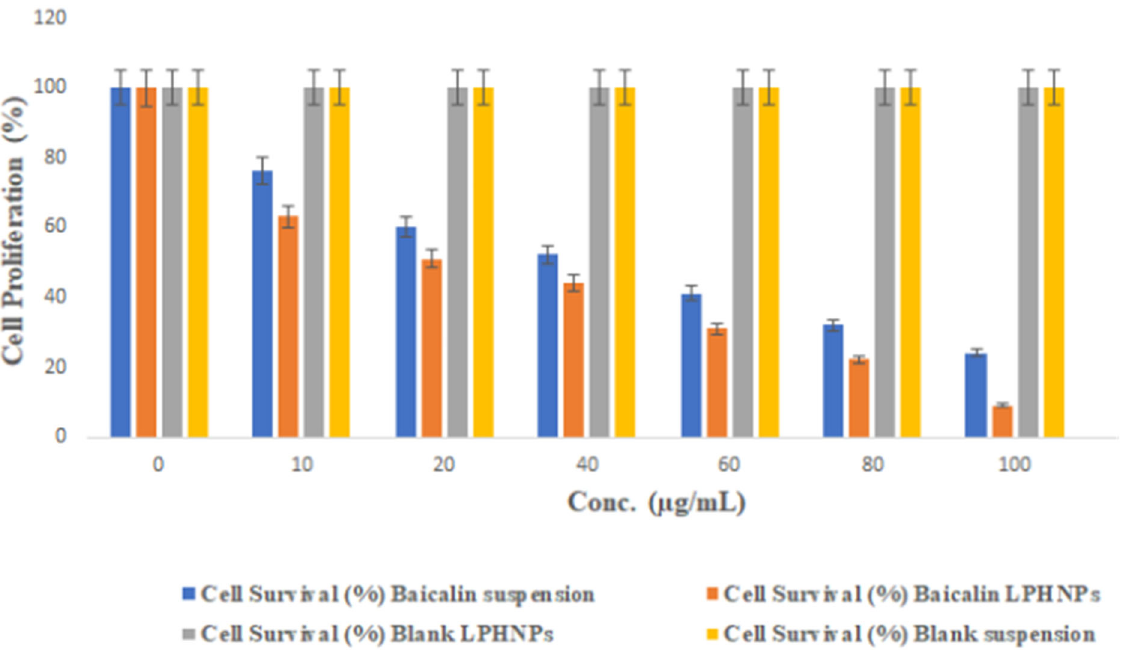
Figure 5. Evaluation of baicalin suspension, baicalin LPHNP, and blank LPHNP at various levels after the incubation of HCT-116 cells for ( A ) 24 h and ( B ) 48 h (LPHNPs; lipid polymeric hybrid nanoparticles). All the values were presented as mean ± SD of three independent experiments. One-way ANOVA was used for the statistical analysis. The data showed significant ( p < 0.001) cytotoxicity compared with BQ-loaded